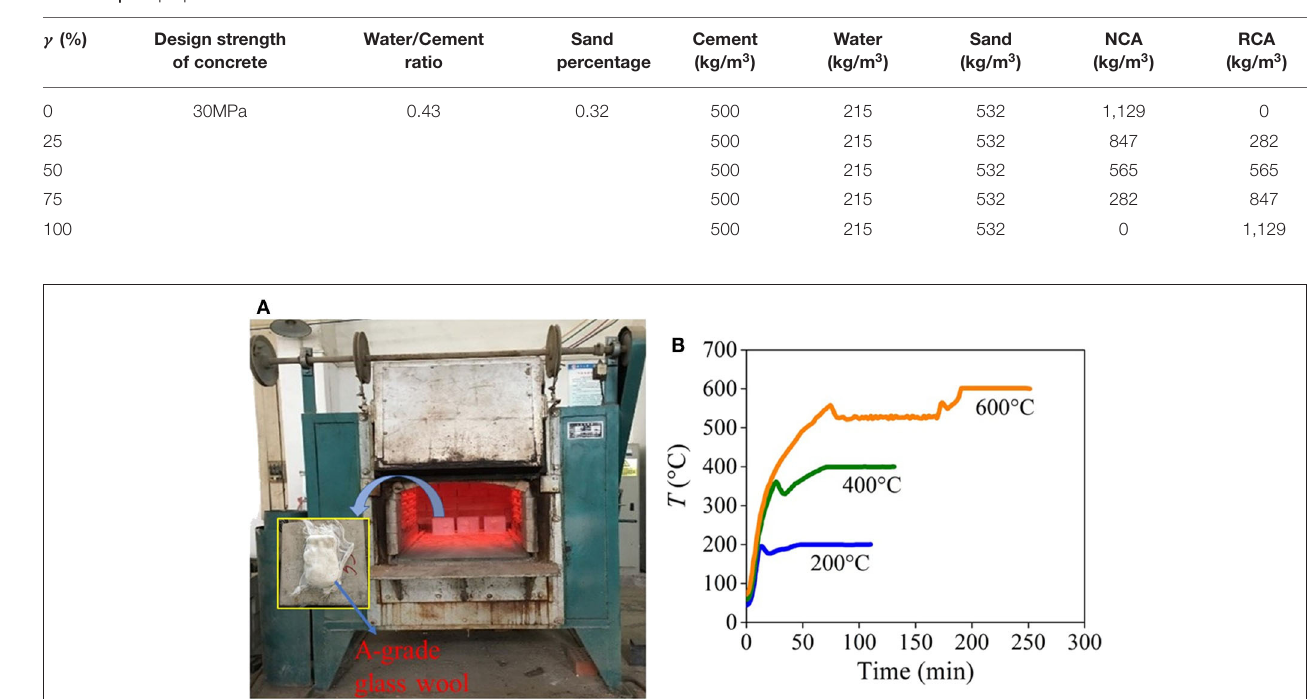
TABLE 2 | Mix proportion of